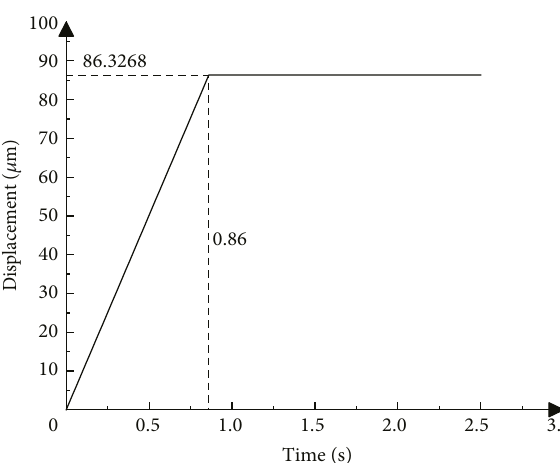
Figure 8: Ramp-constant strain history.